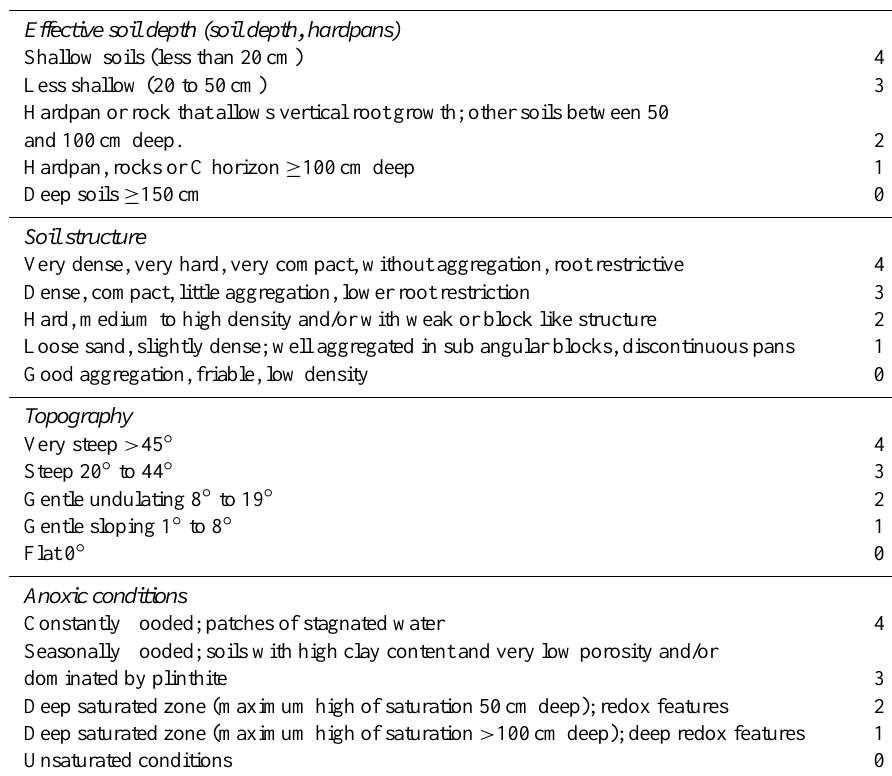
Table 2. Score table for soil physical constraints. Soil physical constraints rating categories Score Effective soil depth (soil depth, hardpans) Shallow soils (less than 20cm) 4 Less shallow (20 to 50cm) 3 Hardpan or rock that allows vertical root growth; other soils between 50 and 100cm deep. 2 Hardpan, rocks or C horizon ≥ 100cm deep 1 Deep soils ≥ 150cm 0